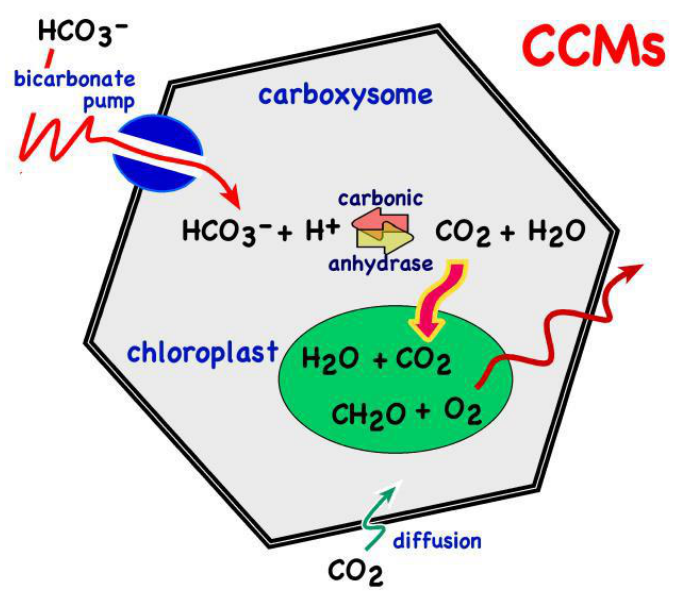
Figure 4. Central to the cyanobacterial CCM (CO 2 Concentrating Mechanism) is the carboxisome, a cellular micro-compartment containing RuBisCo and a carbonic anhydrase (CA) that, by converting HCO 3 − into CO 2 , concentrates CO 2 as much as 1000-fold around the active site of RuBisCO [46]. (This figure is an original interpretation by L. Pomar based on several sources).